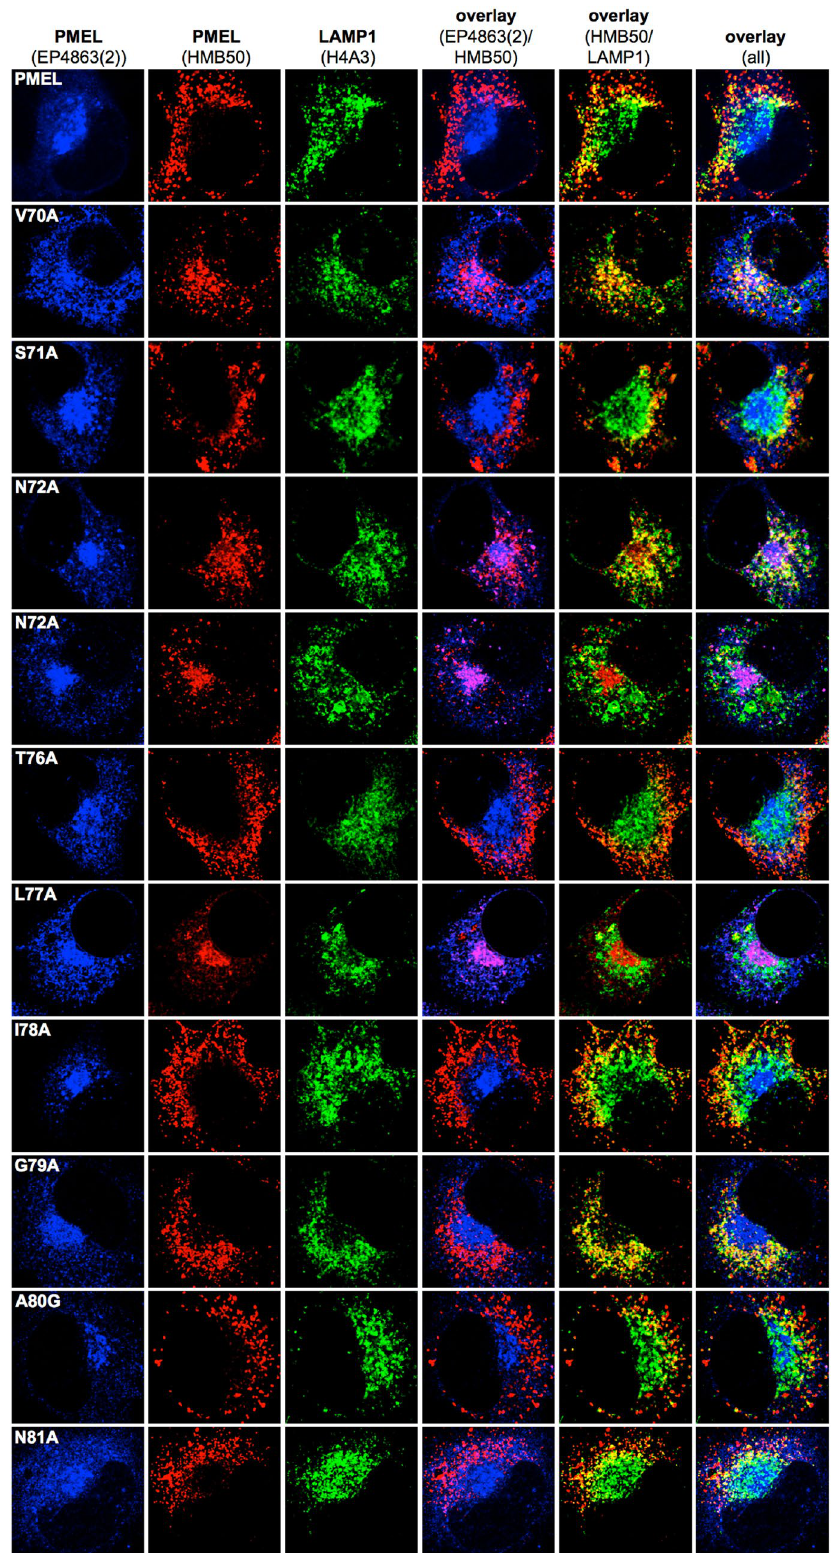
Figure 2. Subcellular trafficking and melanosome-lysosome segregation of PMEL alanine-scanning mutants. Immunofluorescence analysis of Mel220 cells stably expressing PMEL alanine-scanning mutants. The antibody EP4863(2) recognizes newly synthesized, but not fibrillar PMEL. The PMEL-specific antibody HMB50 recognizes mature melanosomal fibrils. The LAMP1-specific antibody H4A3 recognizes a lysosomal marker. Note that proper PMEL amyloid formation typically correlates in this assay with a significant separation of the perinuclear lysosomal staining (LAMP1) from the largely peripheral melanosomal staining